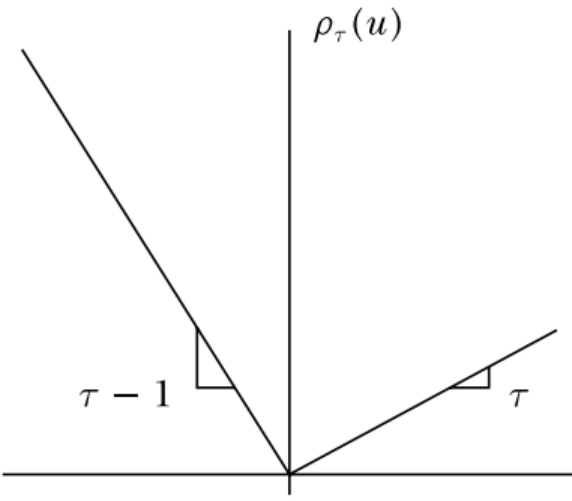
Figure 1. Quantile Regression ρ